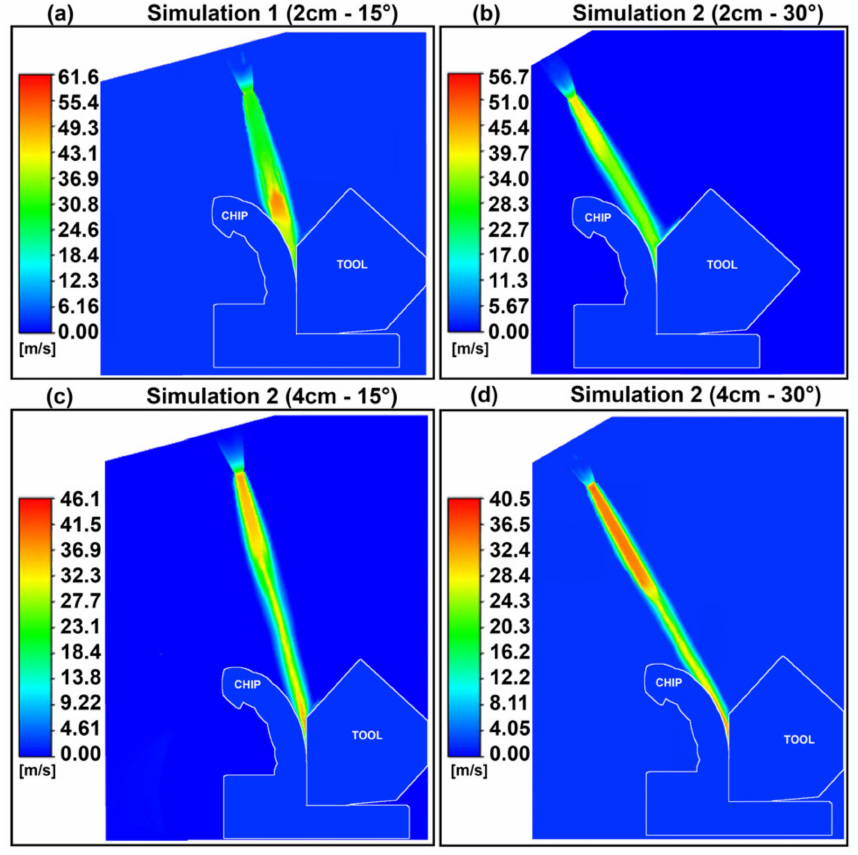
Figure 8. Jet velocity profiles (in